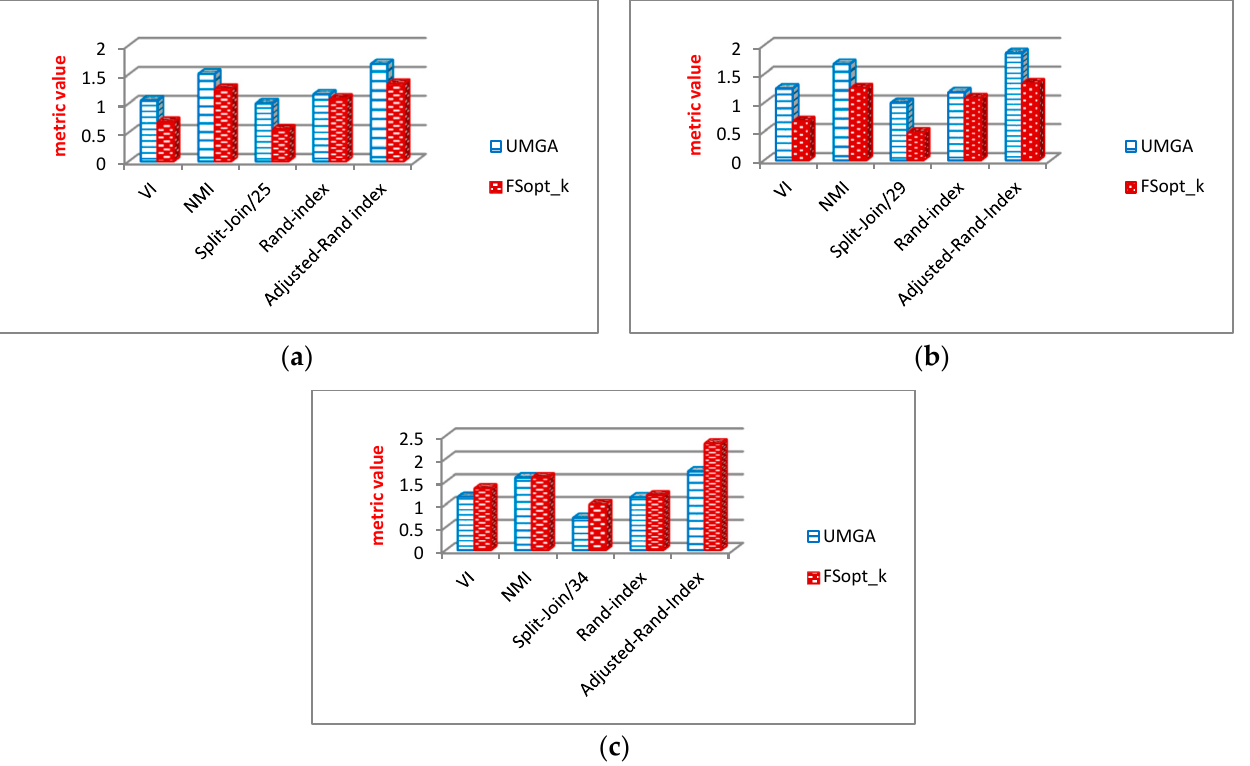
Figure 13. Evaluated values of community structure metrics on Dolphins for ( a ): ℒ = 0.05 , ( b ): ℒ = 0.1 , and ( c ): ℒ = 0.2 .